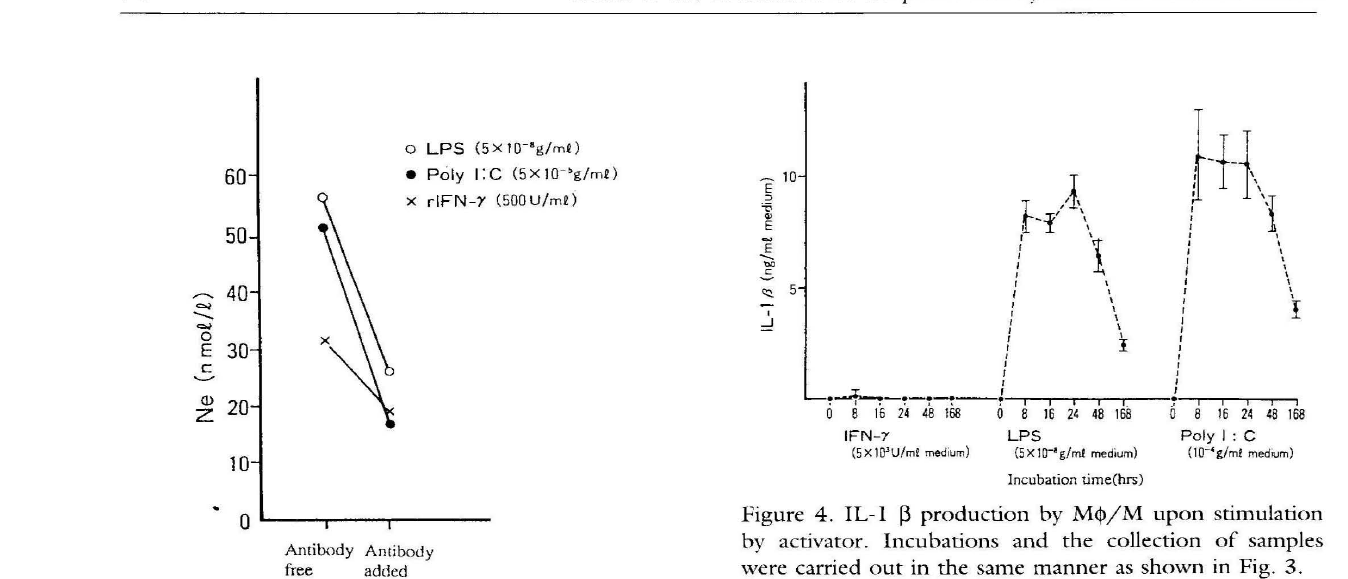
rigure 4. IL-l 13 production by M<j>/M upon stimulation by activator. Incubations and the collection of samples were carried out in the same manner as shown in Fig. 3.